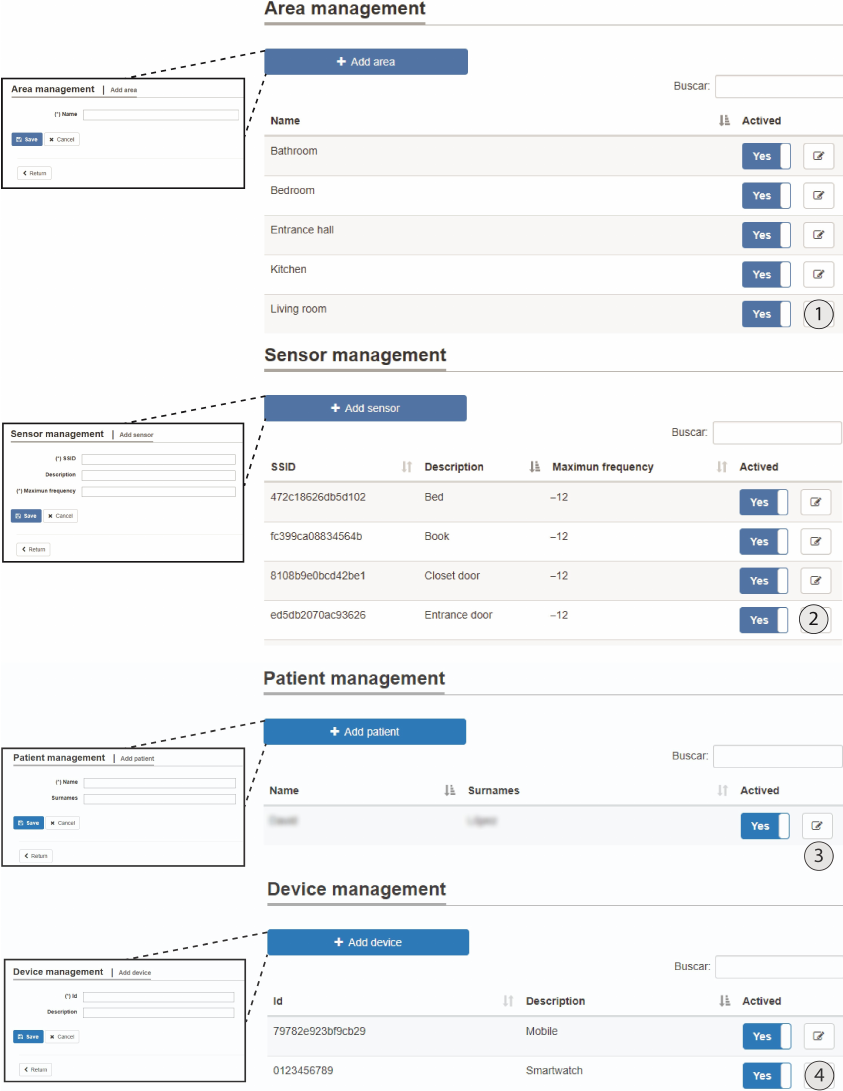
Figure 11. ( 1 ) Area management, ( 2 ) sensor management, ( 3 ) inhabitant management, and ( 4 ) de- vice